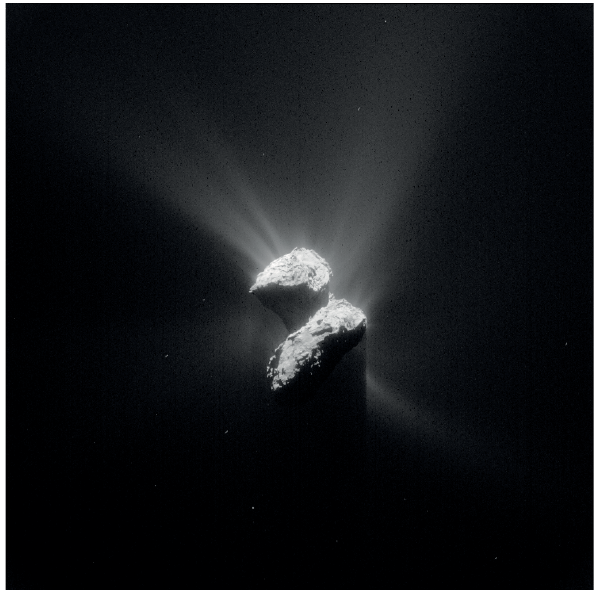
Figure 1. NAVCAM image of comet 67P/CG on 5 June 2015, showing the structuredness of the escaping dust from the